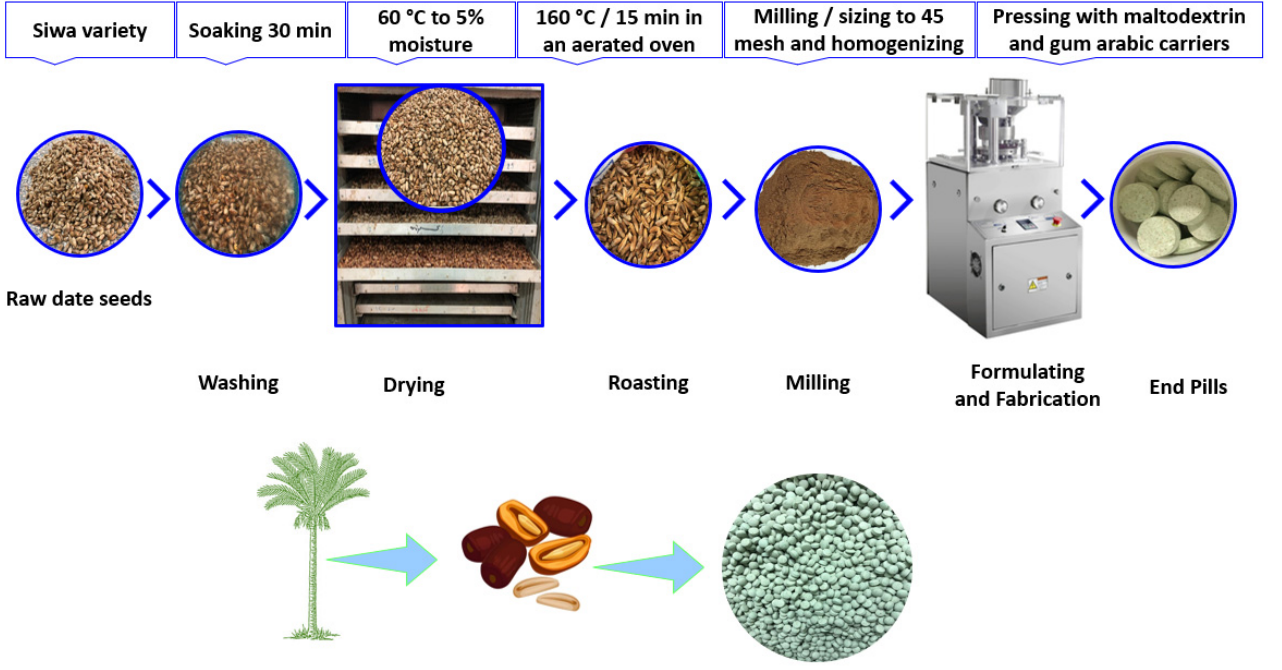
Figure 1. The overall steps required to produce date seed pills under large-scale conditions.